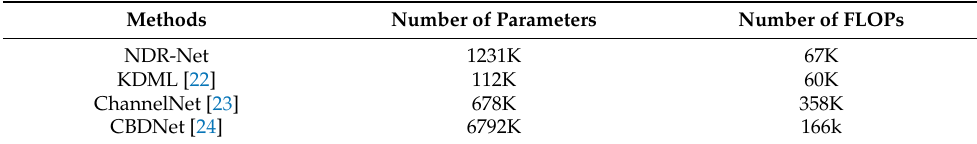
Table 4. The computational complexity of different DL